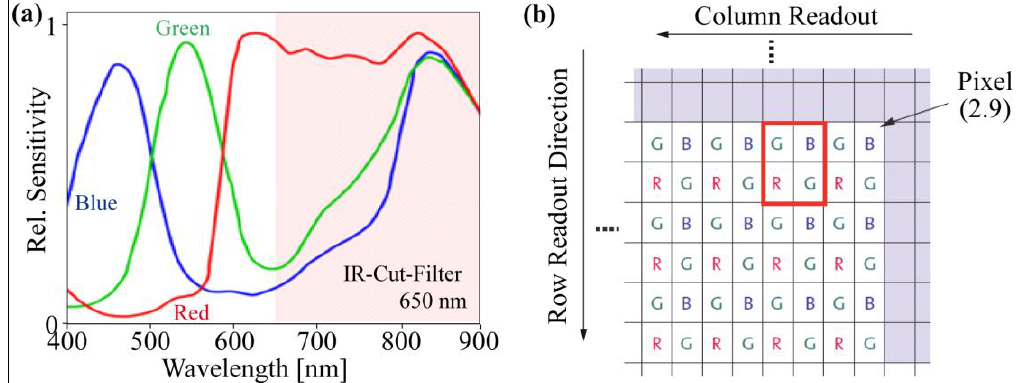
Figure 4. ( a ) The spectral response of the MT9V032STC CMOS image sensor from the IDS datasheet and ( b ) the Bayer pattern from the Aptina datasheet.